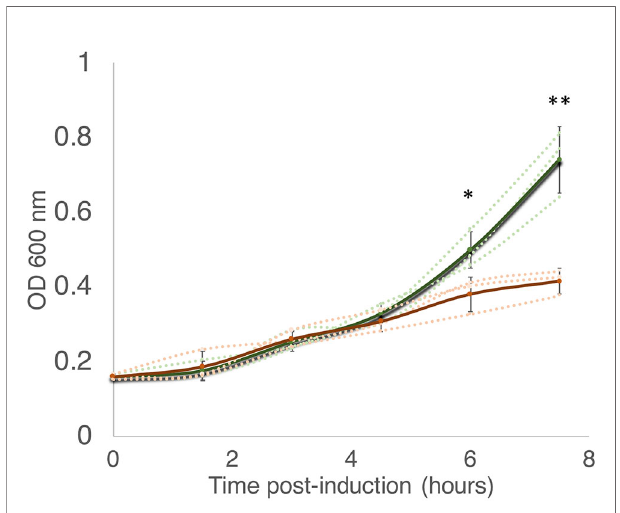
FIGURE 1 | MazF-ms expression in M. smegmatis leads to growth inhibition. M. smegmatis cells harboring pMC1s-MazF-ms were grown in triplicate in supplemented 7H9 media until OD 600nm = ~ 0.16. The cultures were split into induced (+ATC, orange lines) and uninduced (-ATC, green lines) and absorbance at 600 nm was determined every 1.5 h. Error bars represent the standard deviation from the average (solid line) of the three biological replicates (dotted lines). Asterisks represent statistical signi fi cance between induced and uninduced in a Student ’ s t test comparison (*, p-value = 0.011; **, p-value =